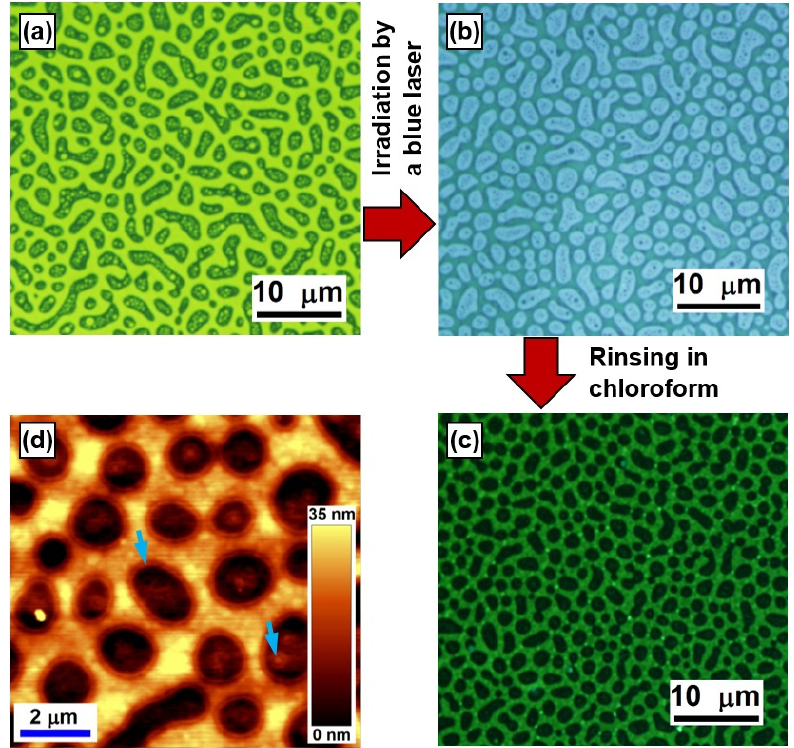
Figure 5. Optical microscopic image of the phase ‐ separation scheme of the F8BT:PFB blend film: before ( a ) and after ( b ) blend film is exposed to a blue laser beam at 457 nm for about 20 min; and ( c ) after the sample is rinsed in chloroform. ( d ) AFM image of the structures shown in ( c ).